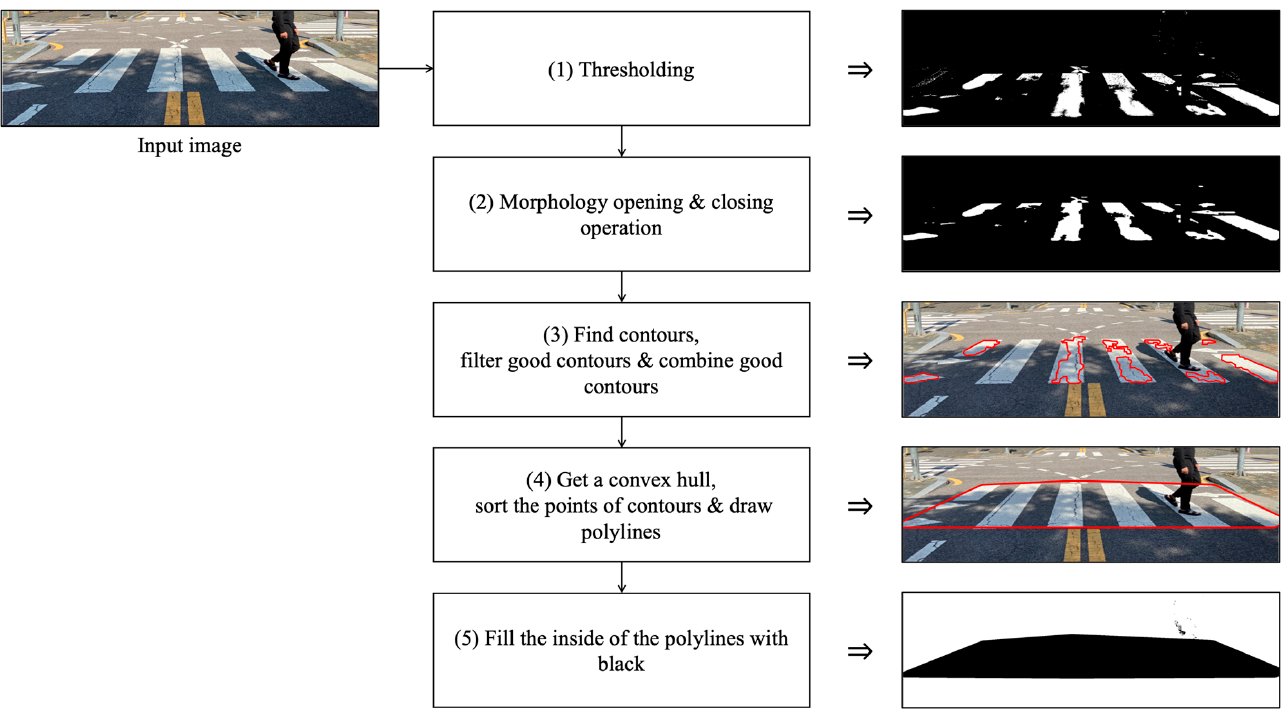
Figure 4. Detecting a crosswalk using the crosswalk detection algorithm (CDA). Algorithm 1: The Crosswalk Detection Algorithm (CDA)